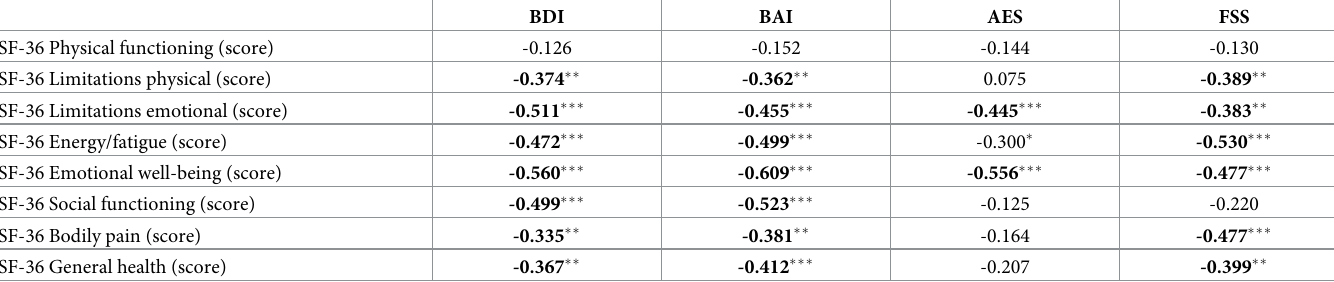
Table 2. Association of neuropsychiatric symptoms with health-related quality of life in clinically isolated syndrome.